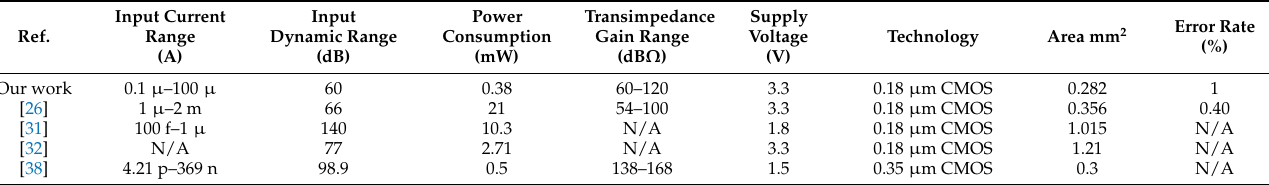
Table 3. Comparison of the proposed readout with existing